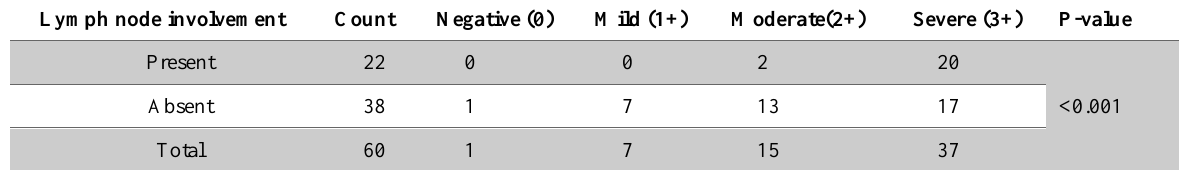
Table 3. The Relationship between SI score and Lymph node involvement